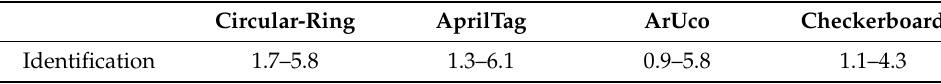
Table 2. The markers distance range of accurate identification [m].